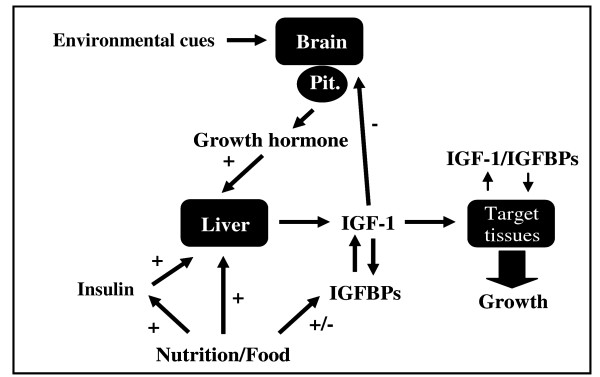
GH/IGF-1 axis. Illustration of the endocrine axis controlling growth in teleost fish. Multiple hormonal and nutritional factors may stimulate (+) the production and/or modify (+/-) the activity of IGF-1. Negative feedback (-) by IGF-1 inhibits growth hormone secretion by the pituitary.